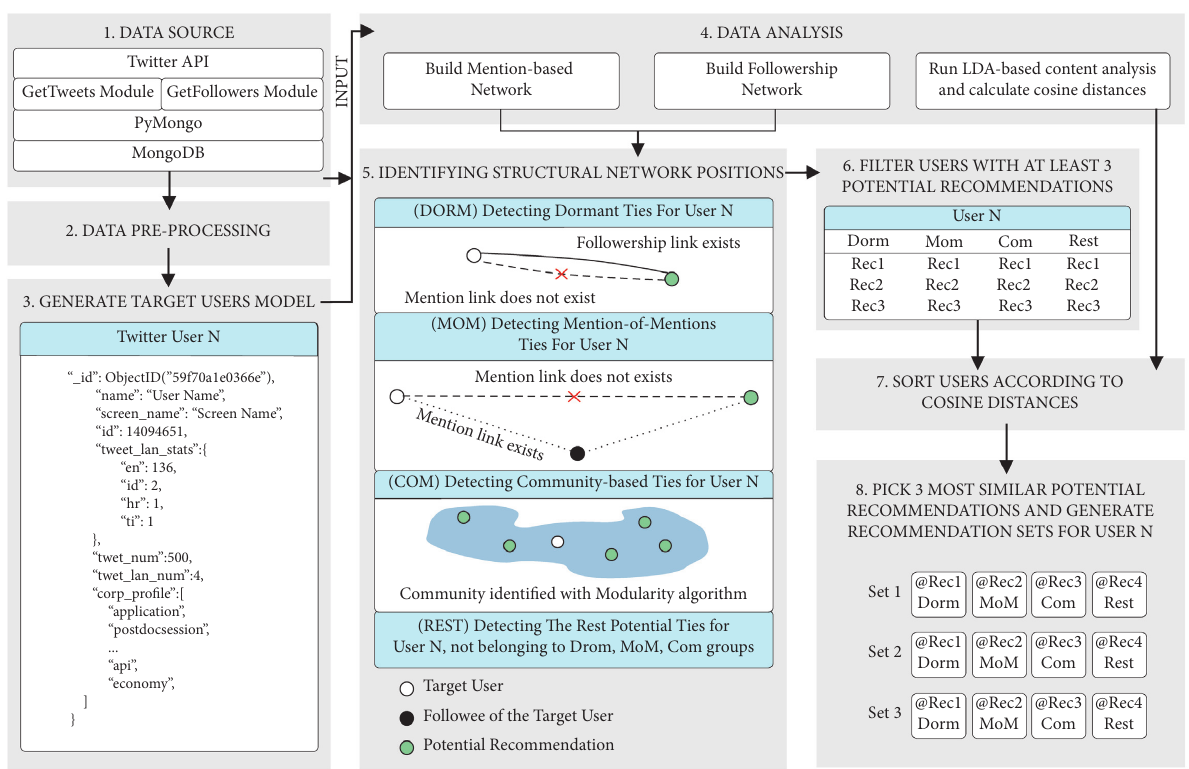
Figure 1: Visual representation of the data collection, analysis procedure, and recommendation